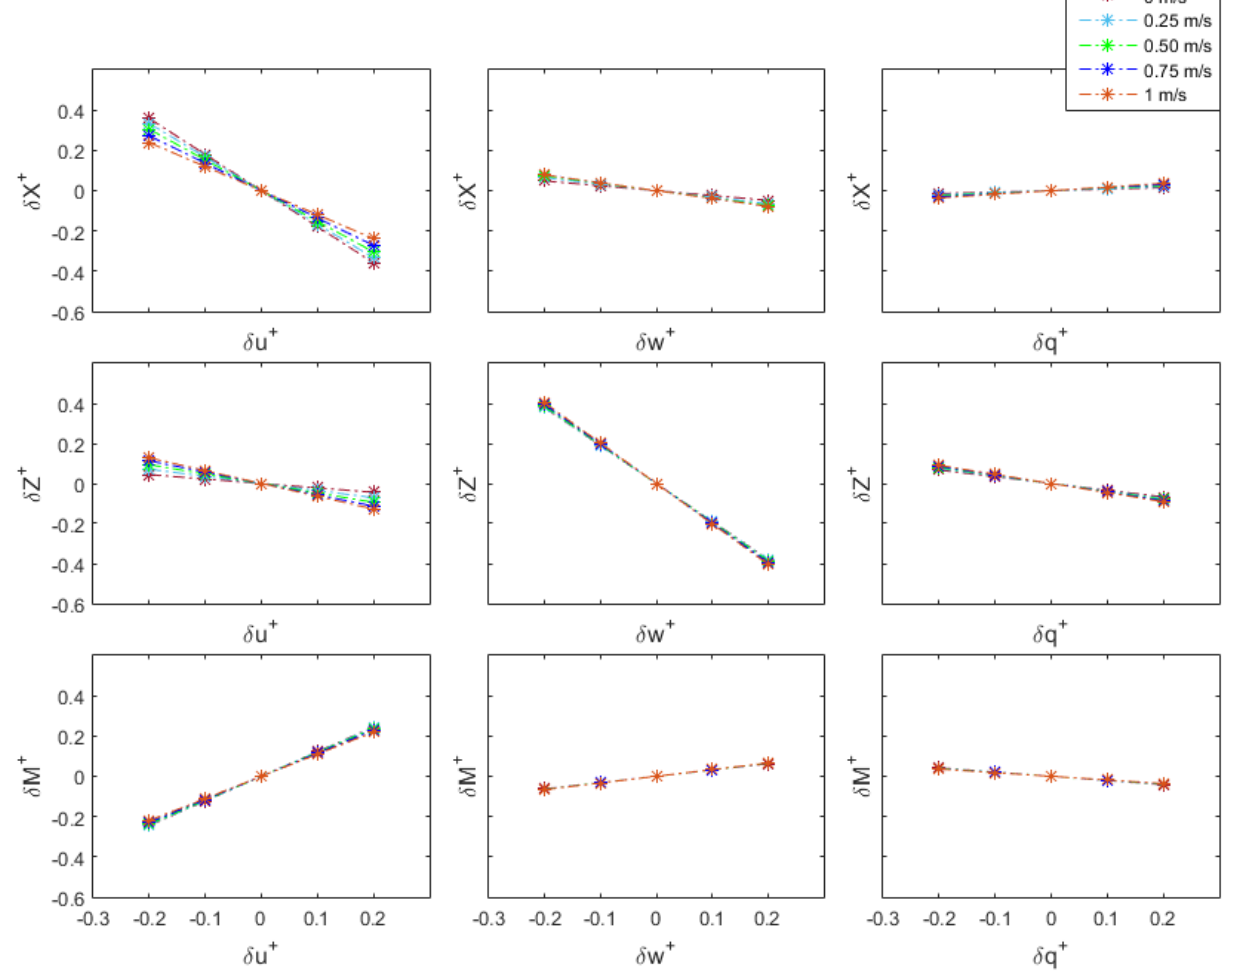
Figure 14. Nondimensionalized longitudinal dynamics stability derivatives for simplified wing kinematics. The longitudinal motion eigenvalues for simplified wing kinematics at various flight speeds are shown in Figure 15. On the leftmost side, there is a stable fast subsidence